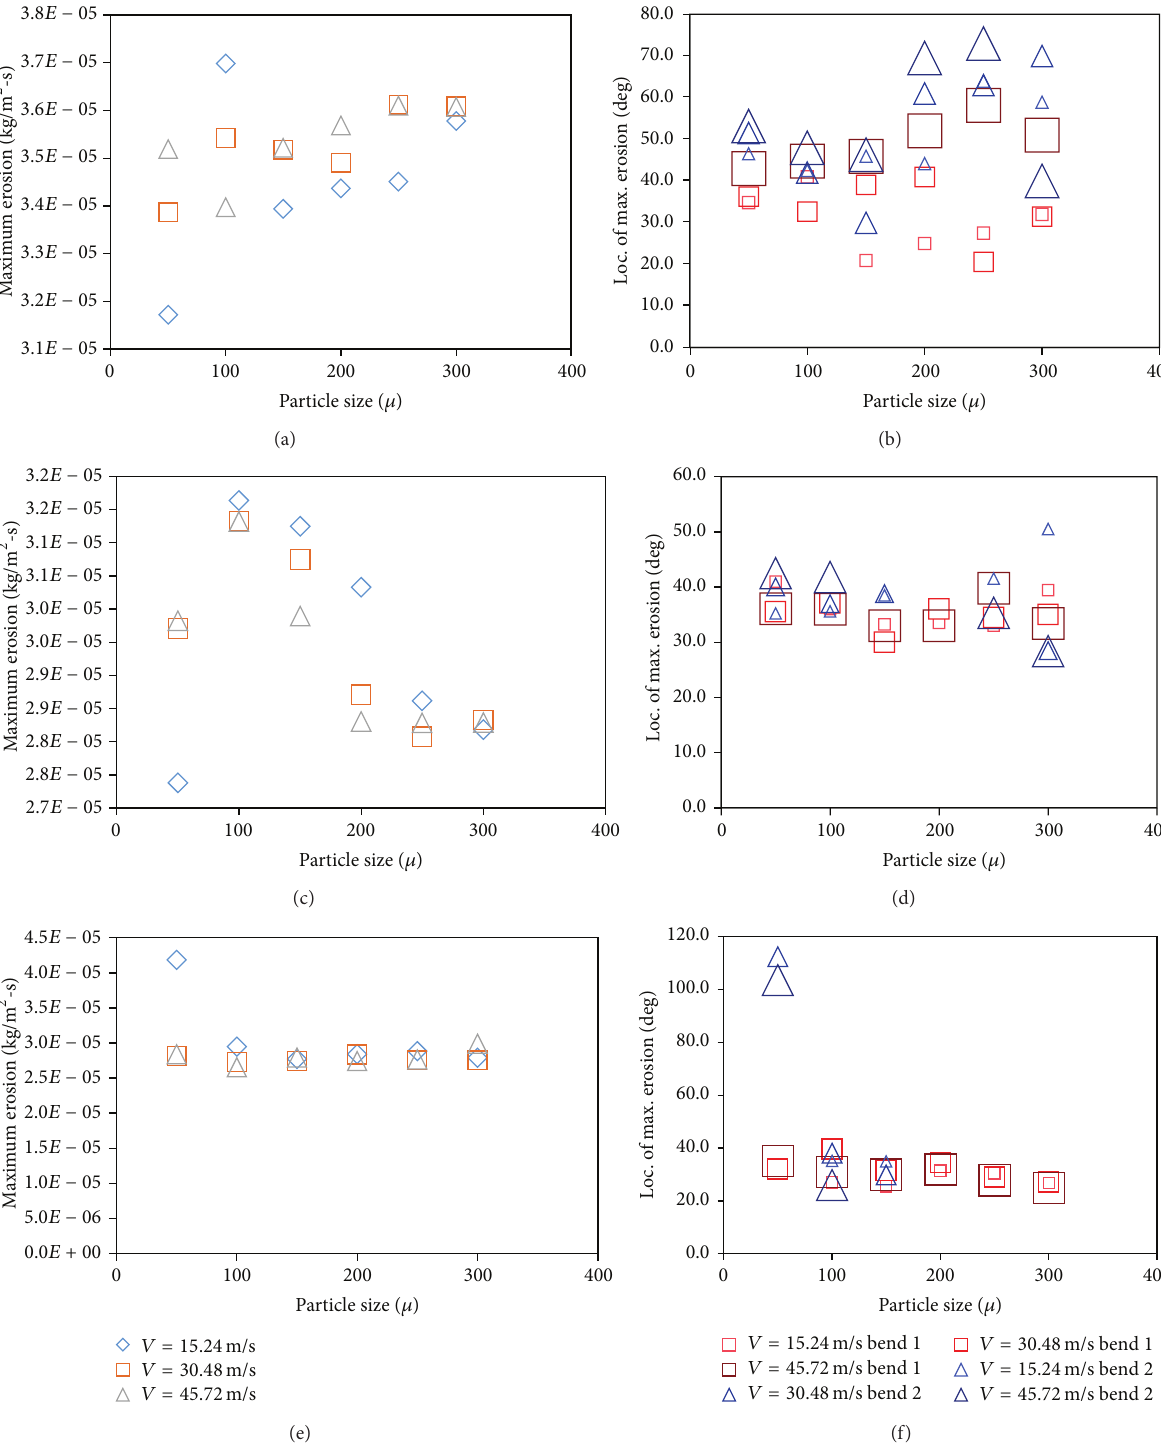
Figure 4: (a) Effect of air velocity on erosion ( 𝑟/𝐷 = 1.5 ). (b) Location of erosion with air velocities ( 𝑟/𝐷 = 1.5 ). (c) Effect of air velocity on erosion ( 𝑟/𝐷 = 2.5 ). (d) Location of erosion at air velocities ( 𝑟/𝐷 = 2.5 ). (e) Effect of air velocity on erosion ( 𝑟/𝐷 = 3.5 ). (f) Location of erosion with air velocities ( 𝑟/𝐷 = 3.5